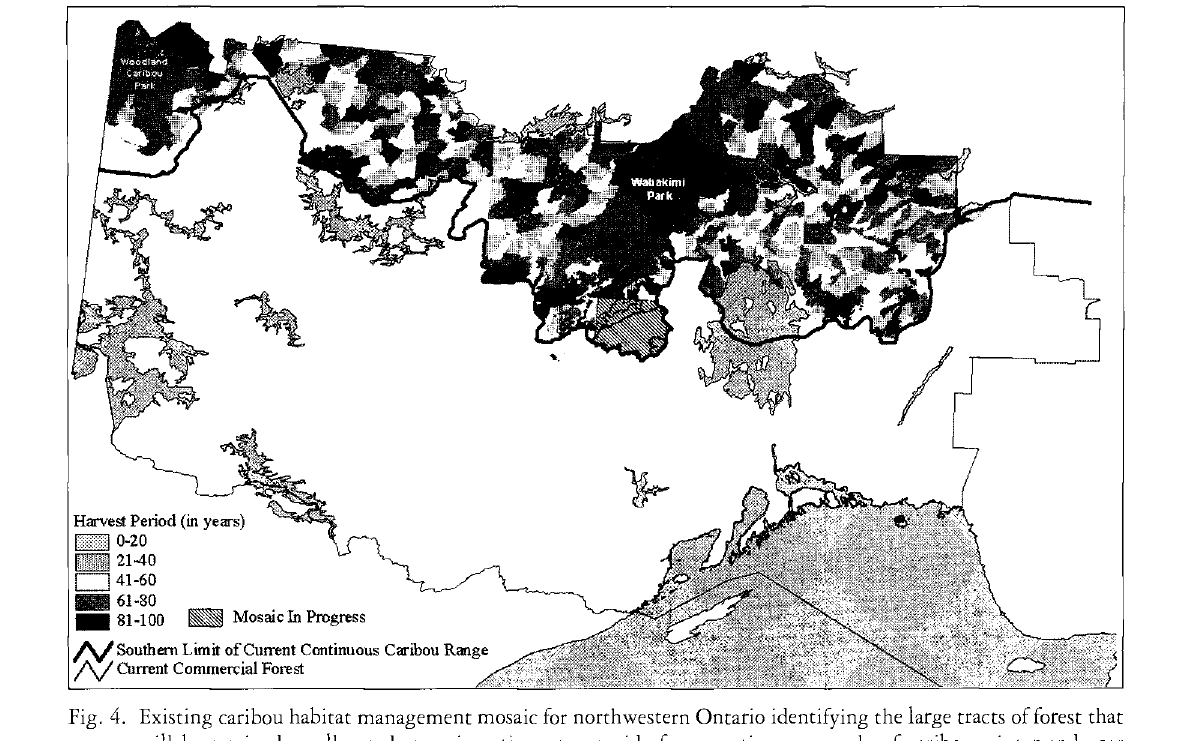
Fig. 4. Existing caribou habitat management mosaic for northwestern Ontario identifying the large tracts of forest that will be retained or allocated at various times to provide for a continuous supply of caribou winter and year round habitat (OMNR